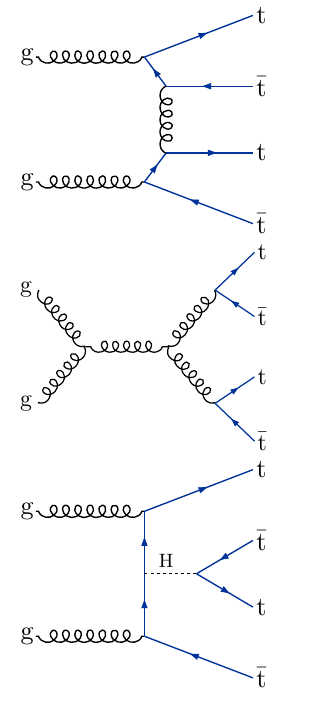
Fig. 1 Representative Feynman diagrams for tttt production at LO in the SM